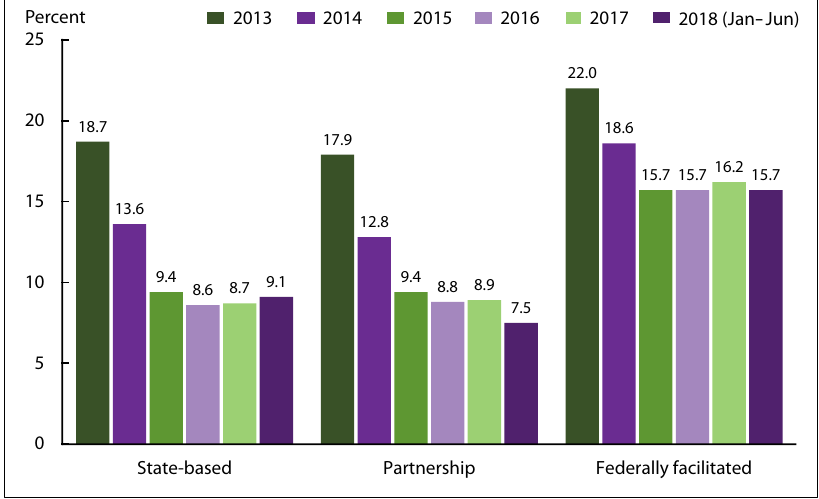
Figure 10. Percentage of adults aged 18–64 who were uninsured at the time of interview, by year and state Health Insurance Marketplace type: United States, 2013–June